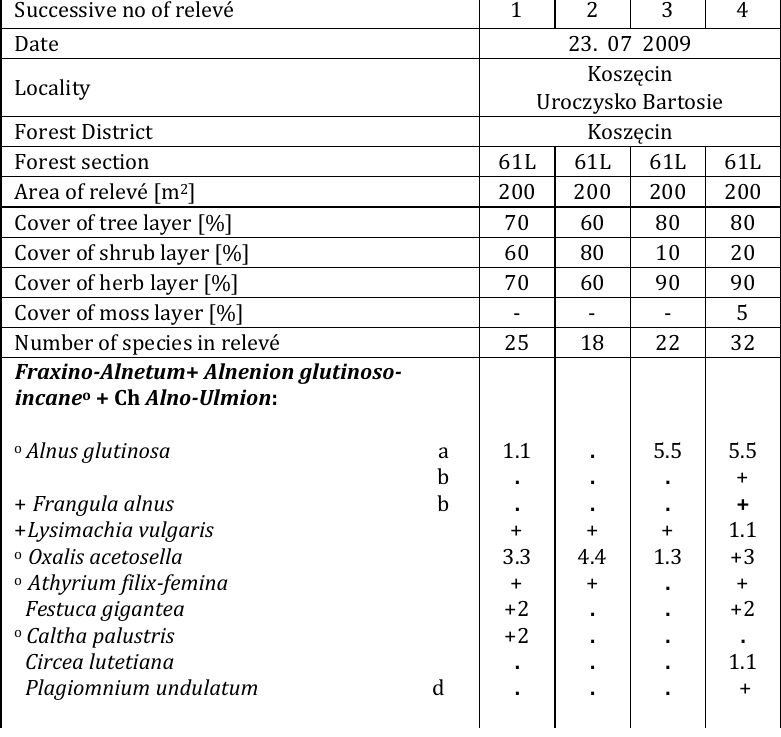
Table 1. Phytosociological differentiation of the plant community with Streptopus amplexifolius from a newly described locality near Koszęcin – (Silesian voivodeship, Southern Poland) (authors) Successive no of